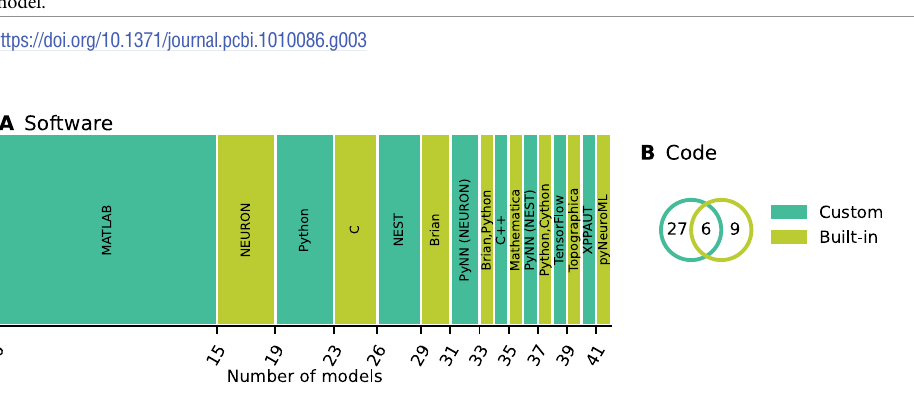
Fig 4. Implementation: How is the connectivity technically implemented? (A) Name of software framework (dedicated simulator or general-purpose software). (B) Implementation of connections. “Custom”: hard-coded; “Built- in”: routine from dedicated simulator. The intersection means that a part of the network connectivity is explicitly coded in a general-purpose language and another part uses built-in simulator functionality.